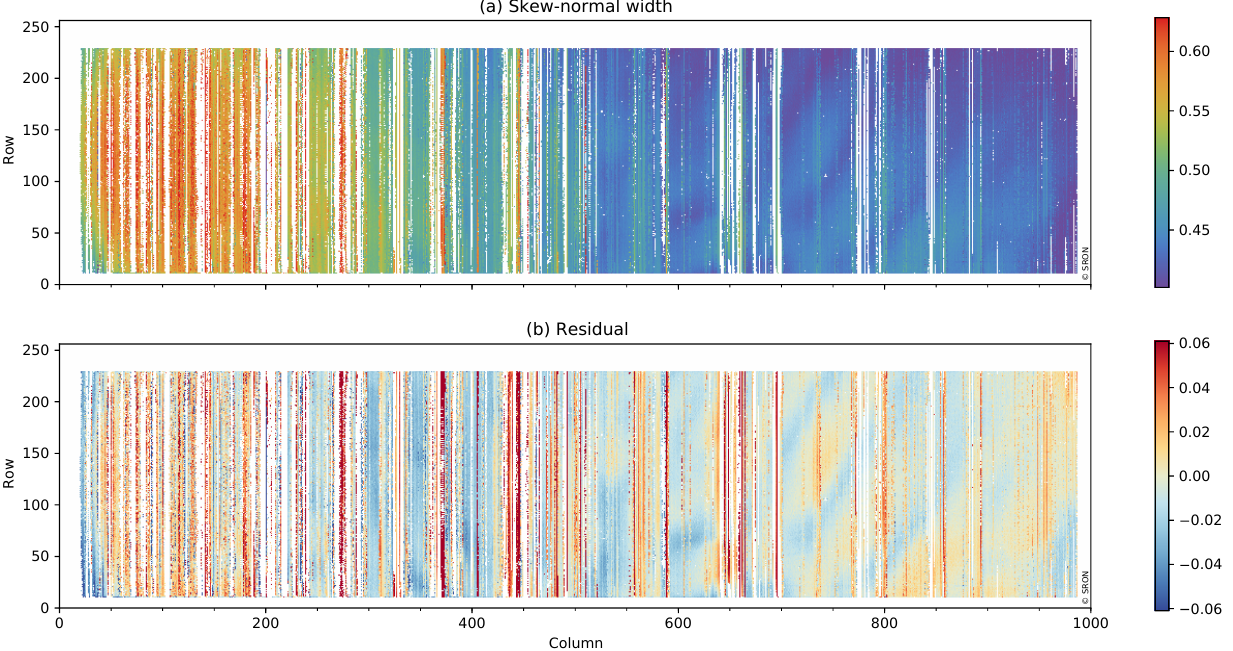
Figure 8. ISRF parameter skew-normal width d (irradiance port). Panel (b) shows the difference between d and its bivariate polynomial fit. No measurements are performed in the white edges. White vertical stripes are due to saturation in the measurements. Red vertical stripes are due to nearby saturation or laser